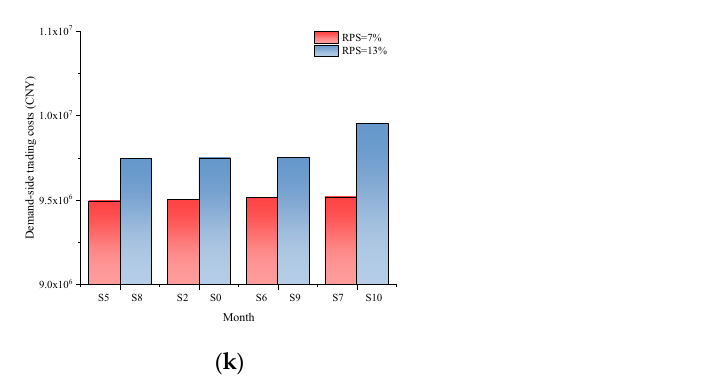
Figure 9. Trends of decision-making and market performance under different TGC price caps. ( a ) Accumulative renewable-power trading volume (RPS weight = 7%). ( b ) Accumulative renewable- power trading volume (RPS weight = 13%). ( c ) TGC price (RPS weight = 7%). ( d ) TGC price (RPS weight = 13%). ( e ) Accumulative TGC trading volume (RPS weight = 7%). ( f ) Accumulative TGC trading volume (RPS weight = 13%). ( g ) Accumulative unsold TGCs (RPS weight = 7%). ( h ) Accumulative unsold TGCs (RPS weight = 13%). ( i ) RPS target completion (RPS weight = 7%). ( j ) RPS target completion (RPS weight = 13%). ( k ) Responsible subjects’ cost.